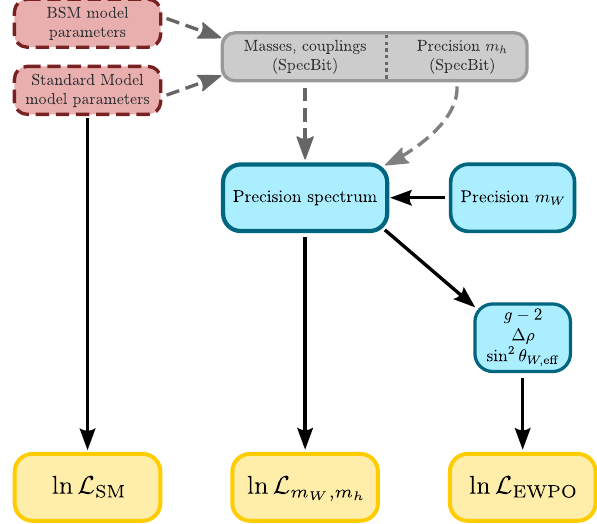
Fig. 9 Schematic representation of the structure of PrecisionBit . Model parameters (red boxes) are used by SpecBit to provide masses andcouplings(greybox)to PrecisionBit ,andtheyarealsousedby Pre- cisionBit directly to compute most SM nuisance likelihoods (left yel- low box). PrecisionBit uses the precision Higgs masses from SpecBit (grey box right), along with its own precision calculation of the W mass (upper-right blue box), to convert the spectrum provided by SpecBit into a precision-updated version (upper-left blue box). It then uses the improvedspectrumforcalculatinglikelihoodsassociatedwiththeHiggs and W masses(middleyellowbox),aswellasasuiteofelectroweakpre- cision observables (EWPO) (lower blue box). It then feeds the EWPO predictions to its own experiment-based EWPO likelihoods (right yel- low